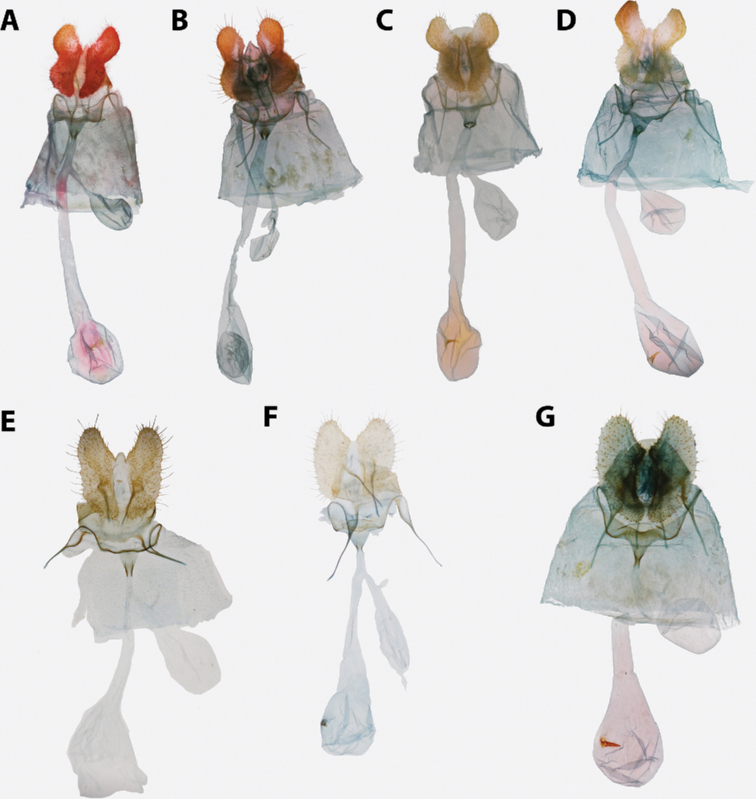
Claduncaria female genitalia. Not to scale. ACla.
maestrana, Cuba. KAA diss. #0154 (VBC) BCla.
ochrochlaena, Dominican Republic. KAA diss. #0126 (CMNH) CCla.
rawlinsana sp. nov. paratype, Dominican Republic. KAA diss. #0122 (CMNH) DCla.
praedictana sp. nov. holotype, Dominican Republic. KAA diss. #0123 (CMNH) ECla.
chalarostium comb. nov., stat. nov. holotype (erroneously labeled as paratype of Argyrotaenia
jamaicana), Jamaica. Razowski diss. #12273 (CMNH) FCla.
minisignaria holotype, Dominican Republic. Razowski diss. #10700 (CMNH) GCla.
mesosignaria, Dominican Republic. KAA diss. #0108 (CUIC).